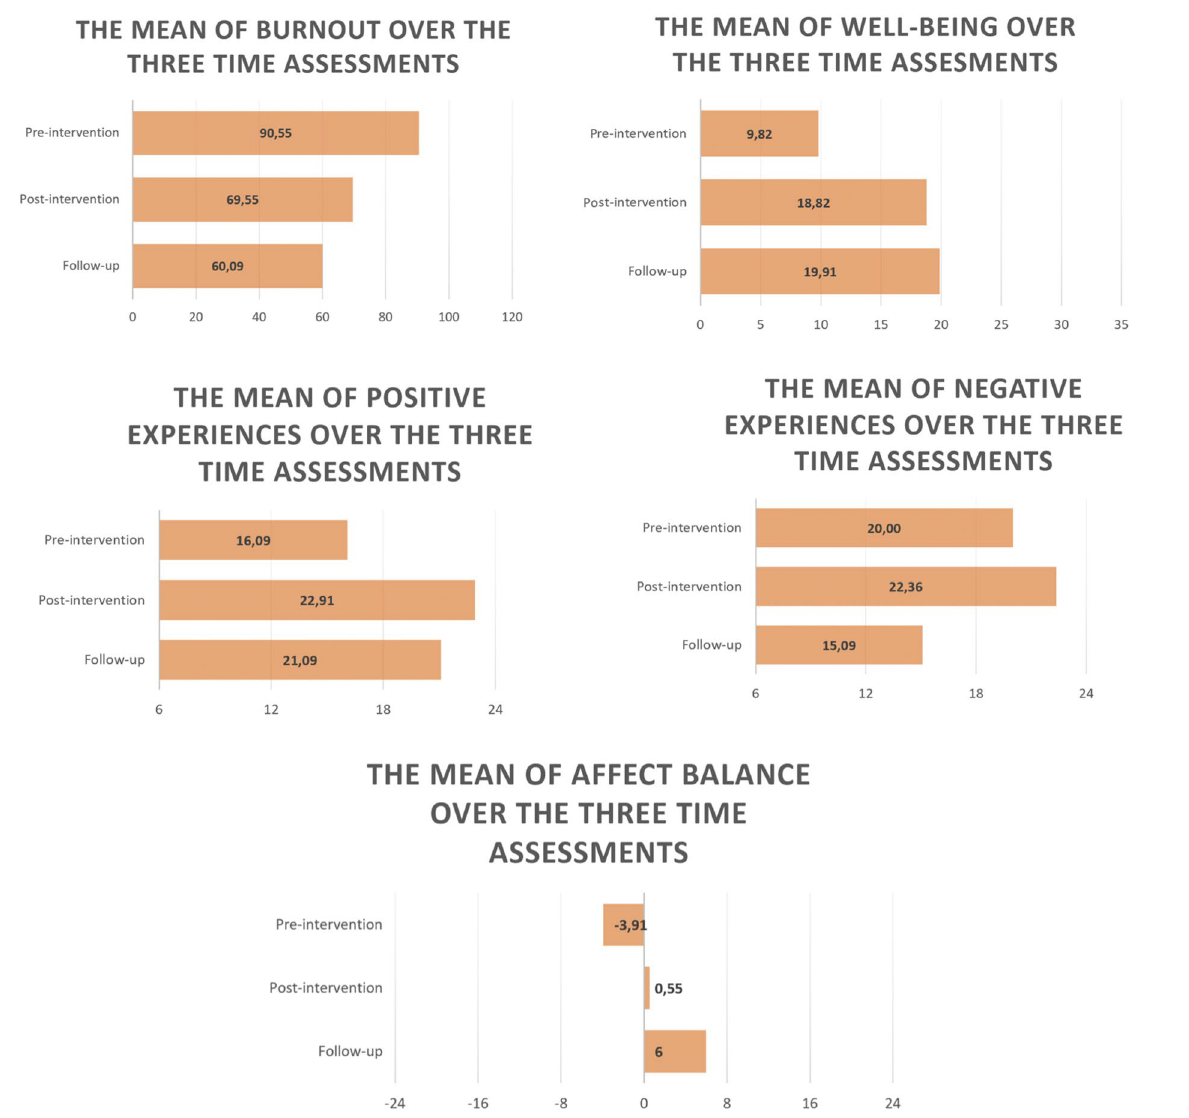
Fig. 2 The evolution of well‑being indicators over time (three time assessments) Source: Authors’